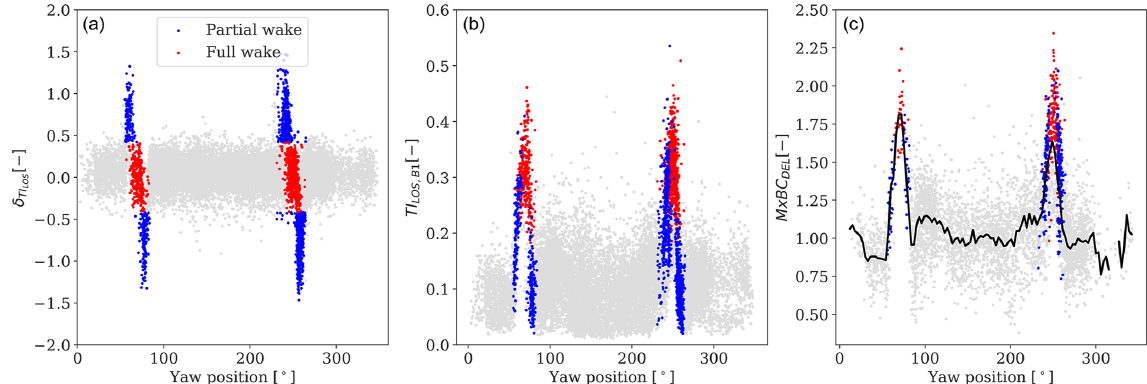
Figure 5. (a, b) PL lidar-estimated 10min wake detection parameters δ TI LOS and TI LOS , B1 , as a function of yaw position. Detected wake situations are shown with coloured markers: wake-free (grey), partial wake (blue), and full wake (red). (c) Measured blade-root flapwise fatigue loads for wind speeds between 8 and 10ms − 1 , normalized over the average load levels in free-wind conditions. The black line shows the average values binned every 3 ◦ in